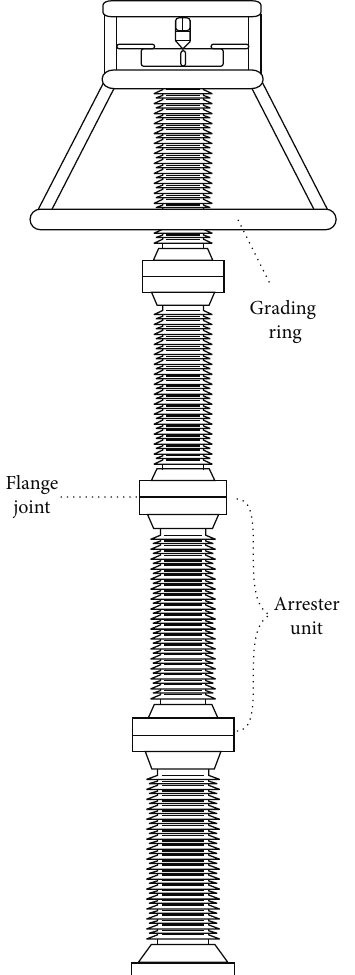
Figure 1: Structural schematic of an UHV porcelain